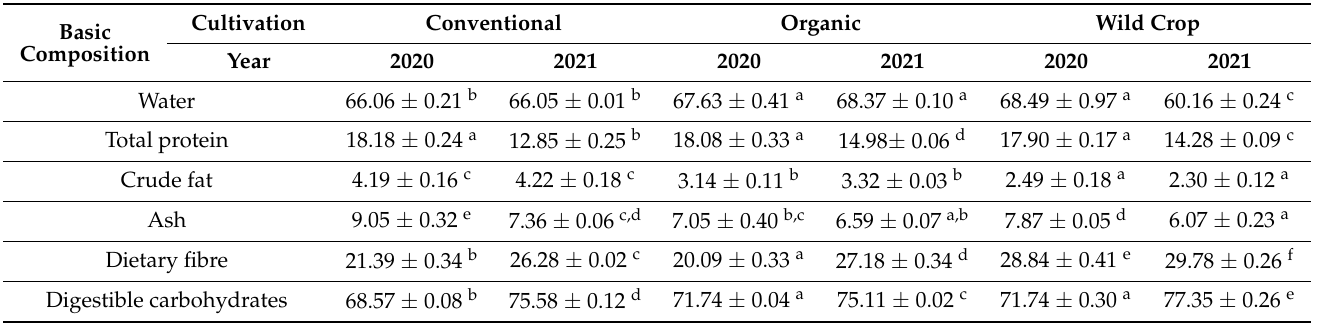
Table 5. Basic composition in leaves of raspberries from conventional and organic practices as well as those wild grown (g 100 g − 1